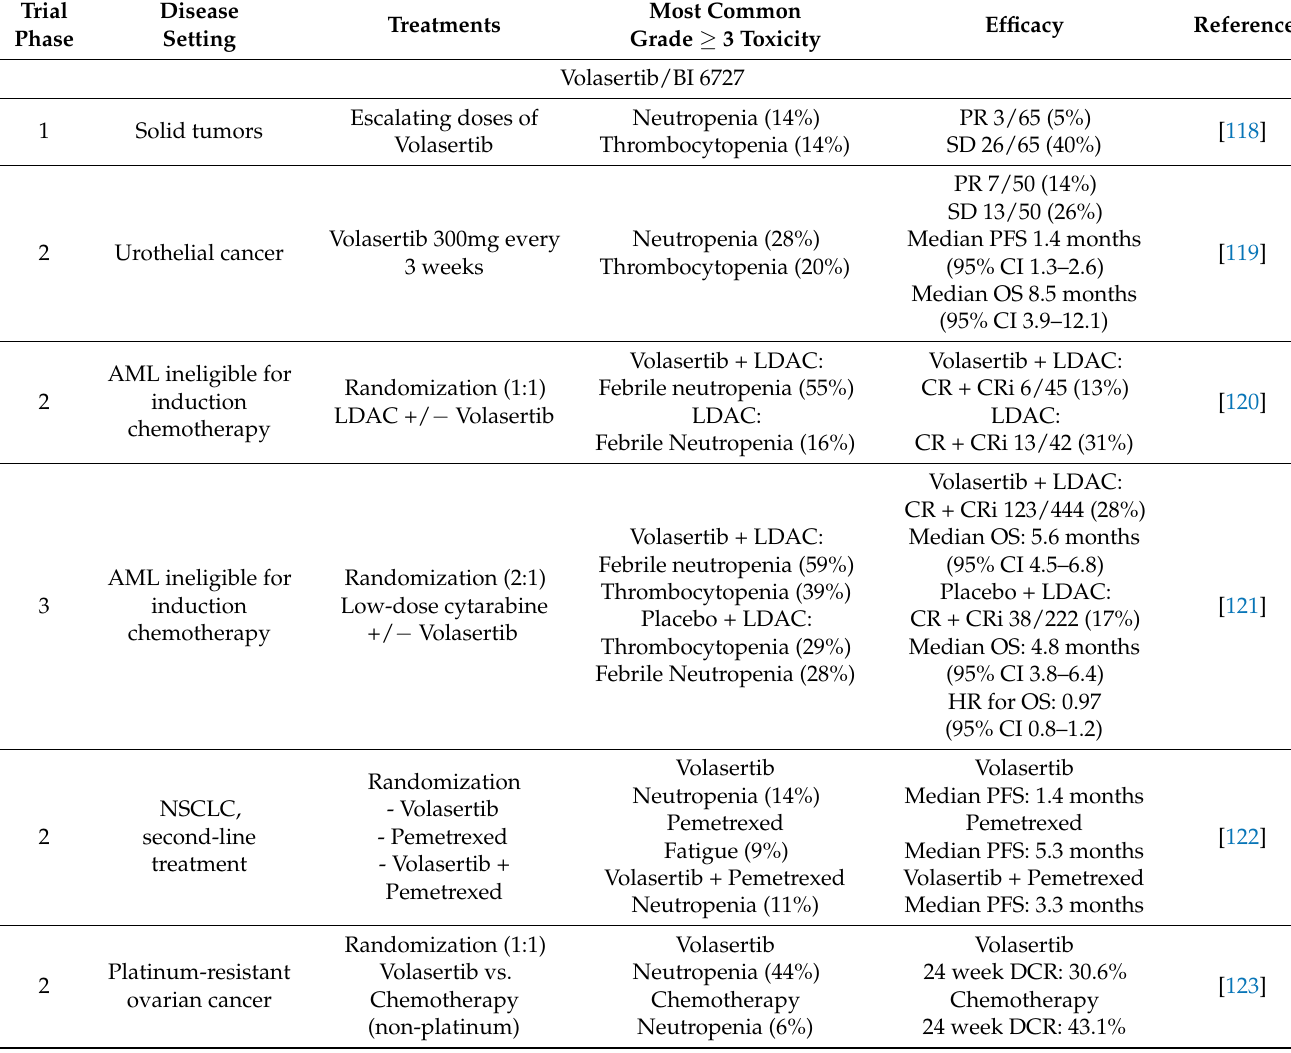
Table 6. Clinical trials of PLK1